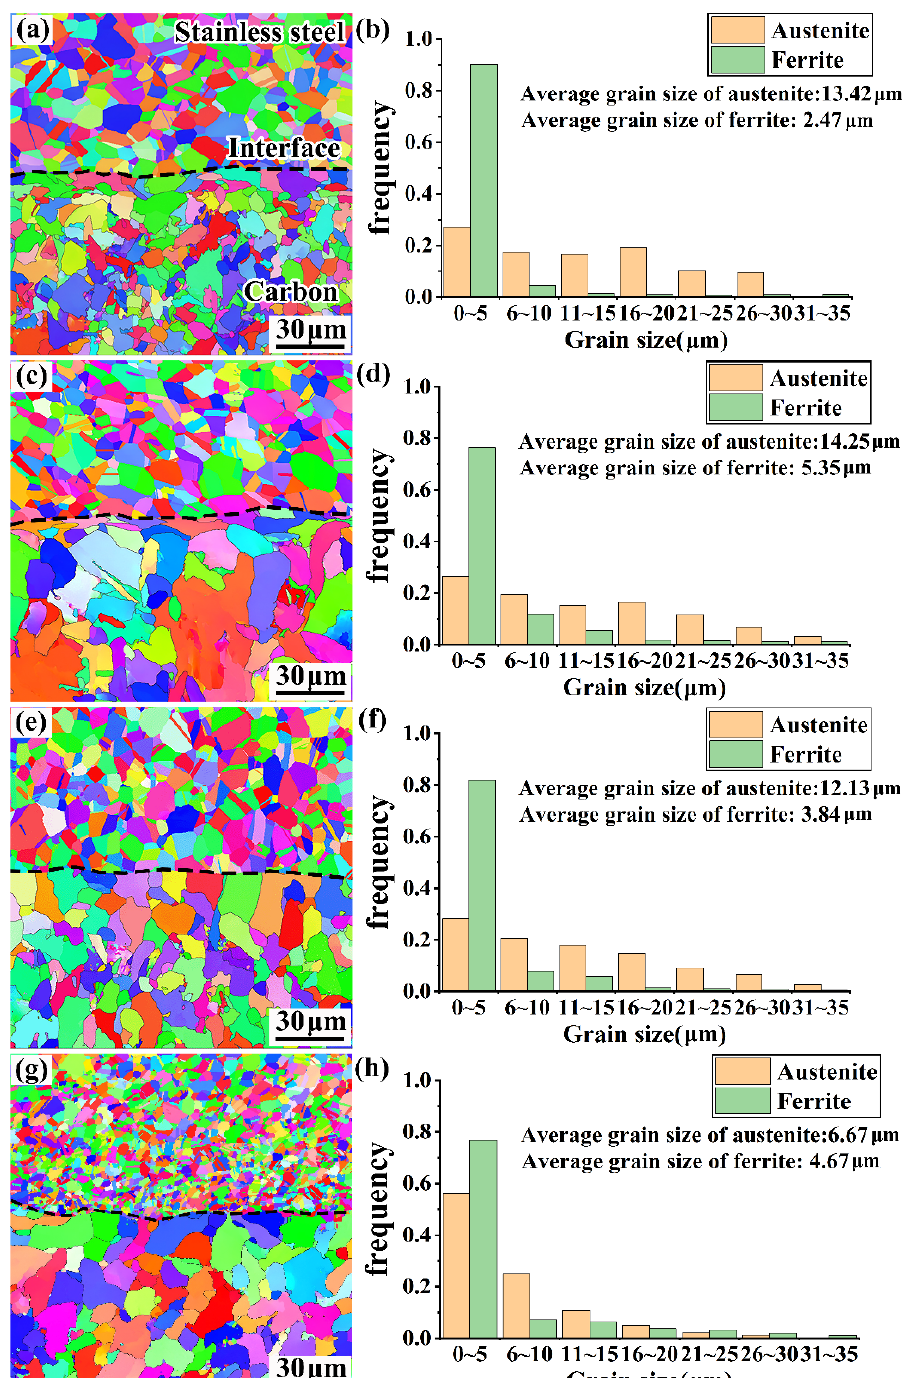
Figure 12. EBSD images and grain distributions for various rebar composite interfaces: ( a , b ) 20MnSiV/316L rebar; ( c , d )35#/316L rebar; ( e , f ) 45#/316L rebar; ( g , h ) 55#/316L rebar.